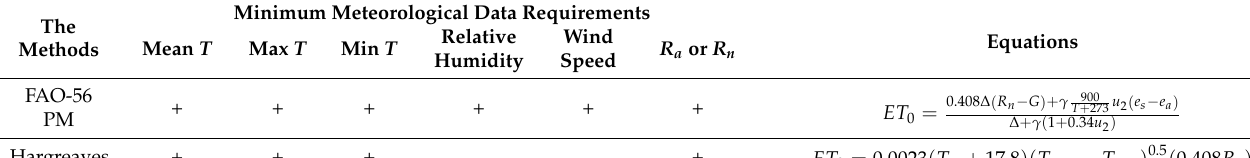
The Methods Table 2. FAO-56 PM, Har and Tho equations with required input data to calculate daily ET 0 . Minimum Meteorological Data The Methods